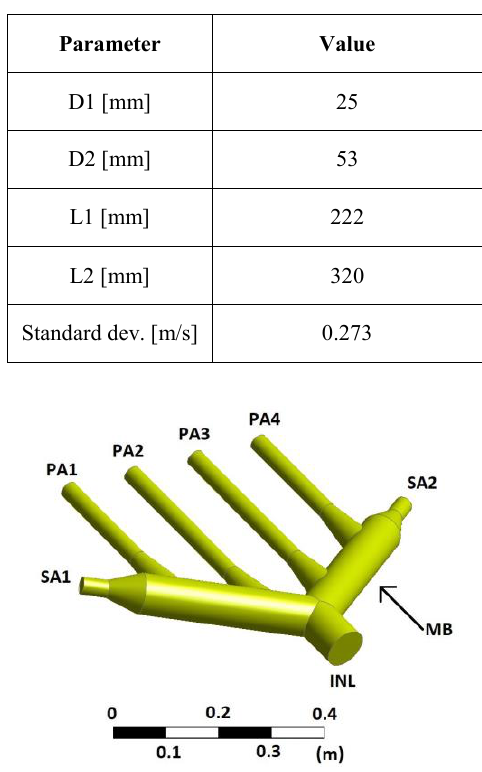
Fig. 8. Spatial geometry of the designed prototype of the air manifold with conical connectors on the primary air ducts.